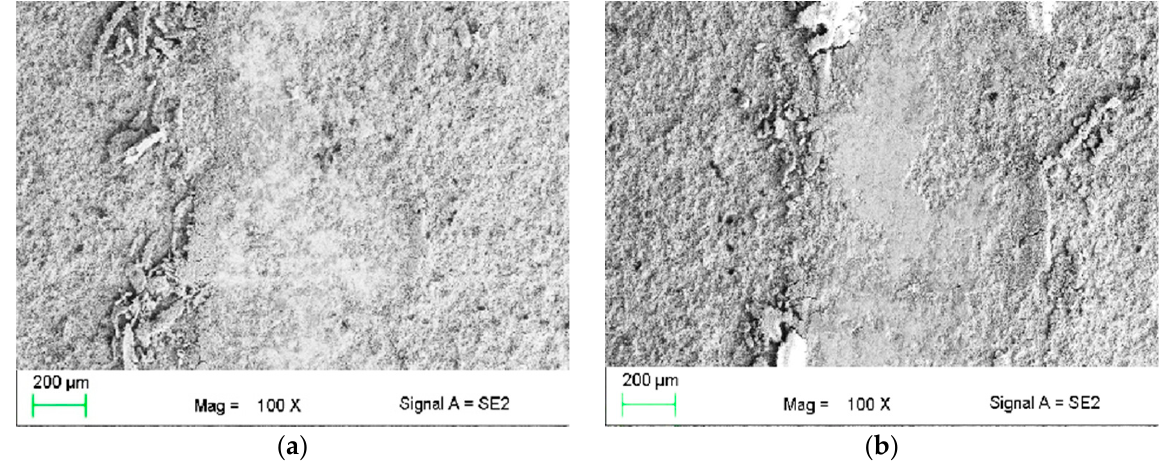
Figure 8. Wear tracks of the ( a ) WC and ( b ) CrC coatings, SEM.